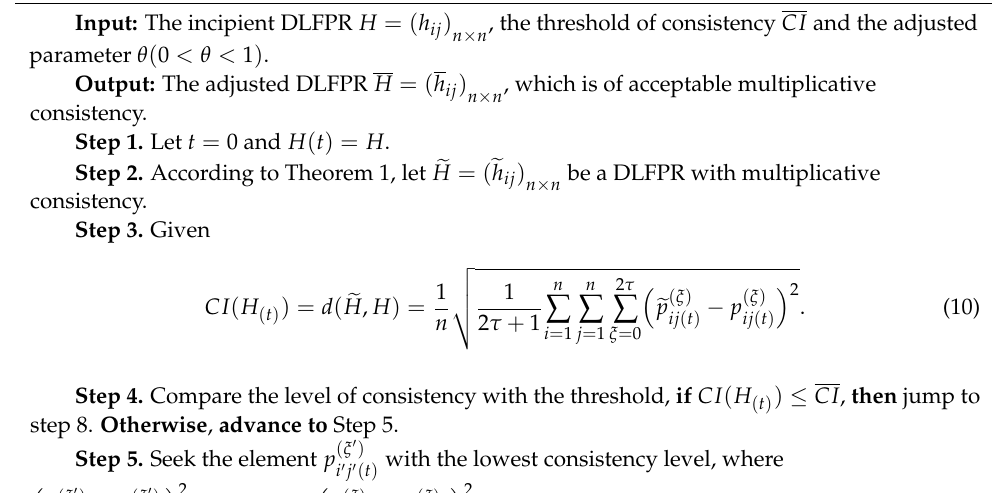
Algorithm 1. Consistency-adjustment process for